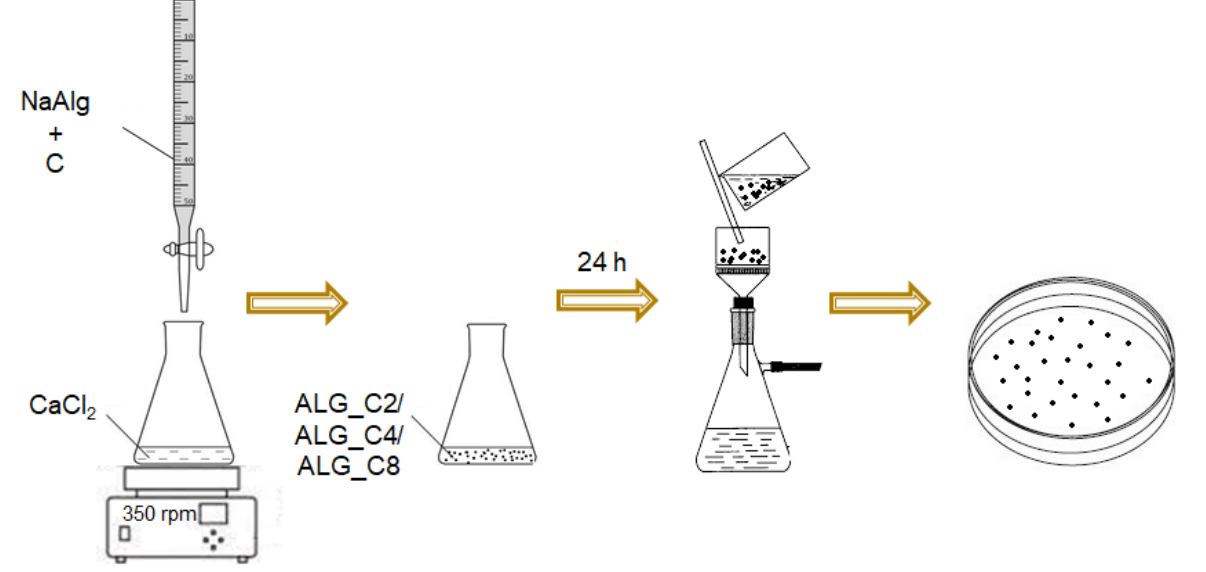
Figure 1. Scheme of obtaining alginate-carbon composites.